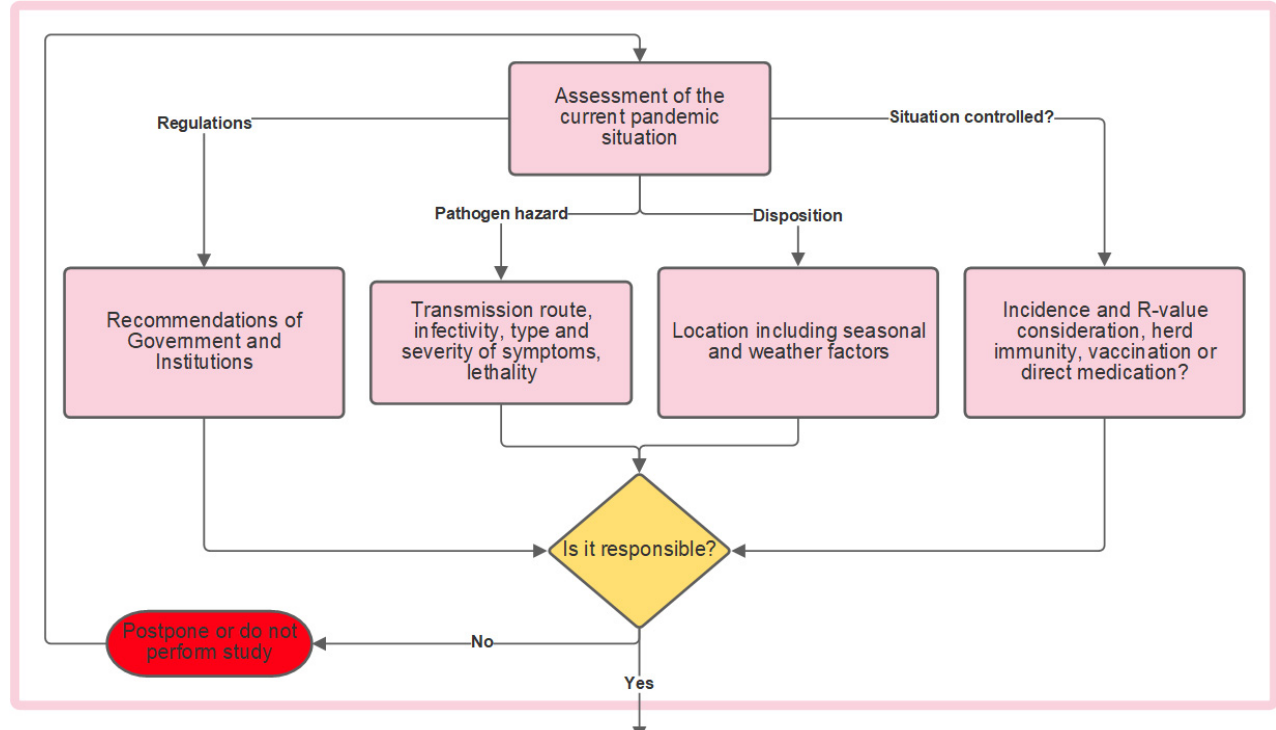
Figure 2. Evaluation of the pandemic situation.